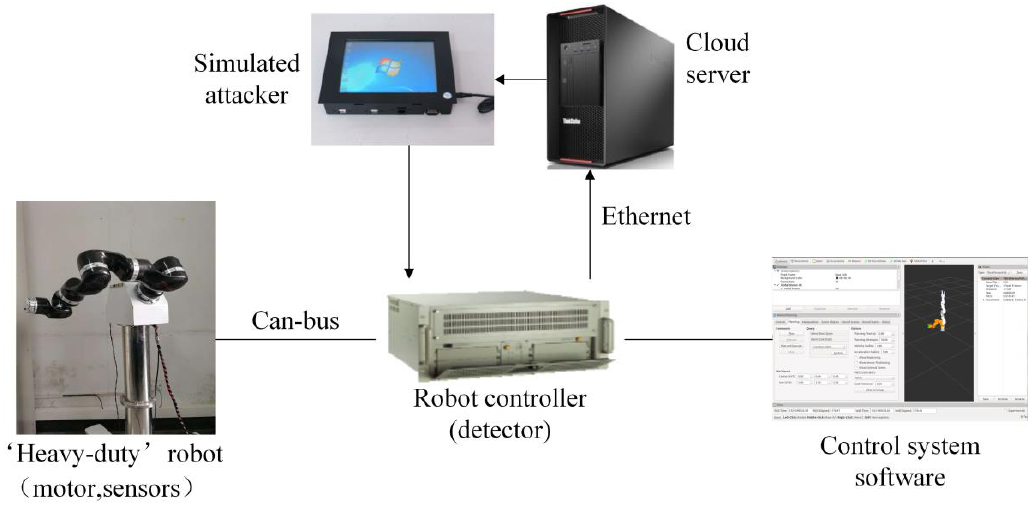
Figure 9. Test platform.